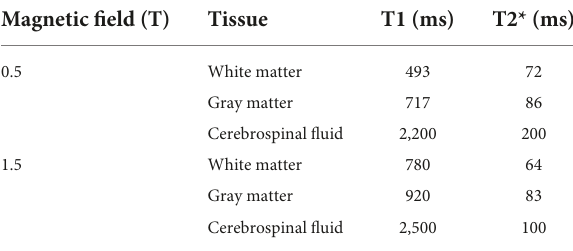
TABLE 1 Parameter table for 0.5T and 1.5T (Peters et al., 2007; Campbell-Washburn et al., 2019). Magnetic field